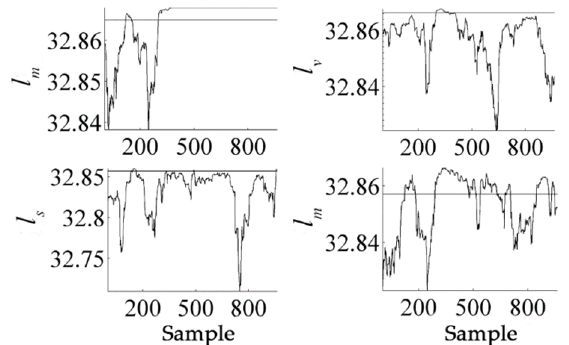
Figure 3. Monitoring results of the improved method for fault 5(the horizontal lines correspond to the confidence limits of the monitoring statistics).